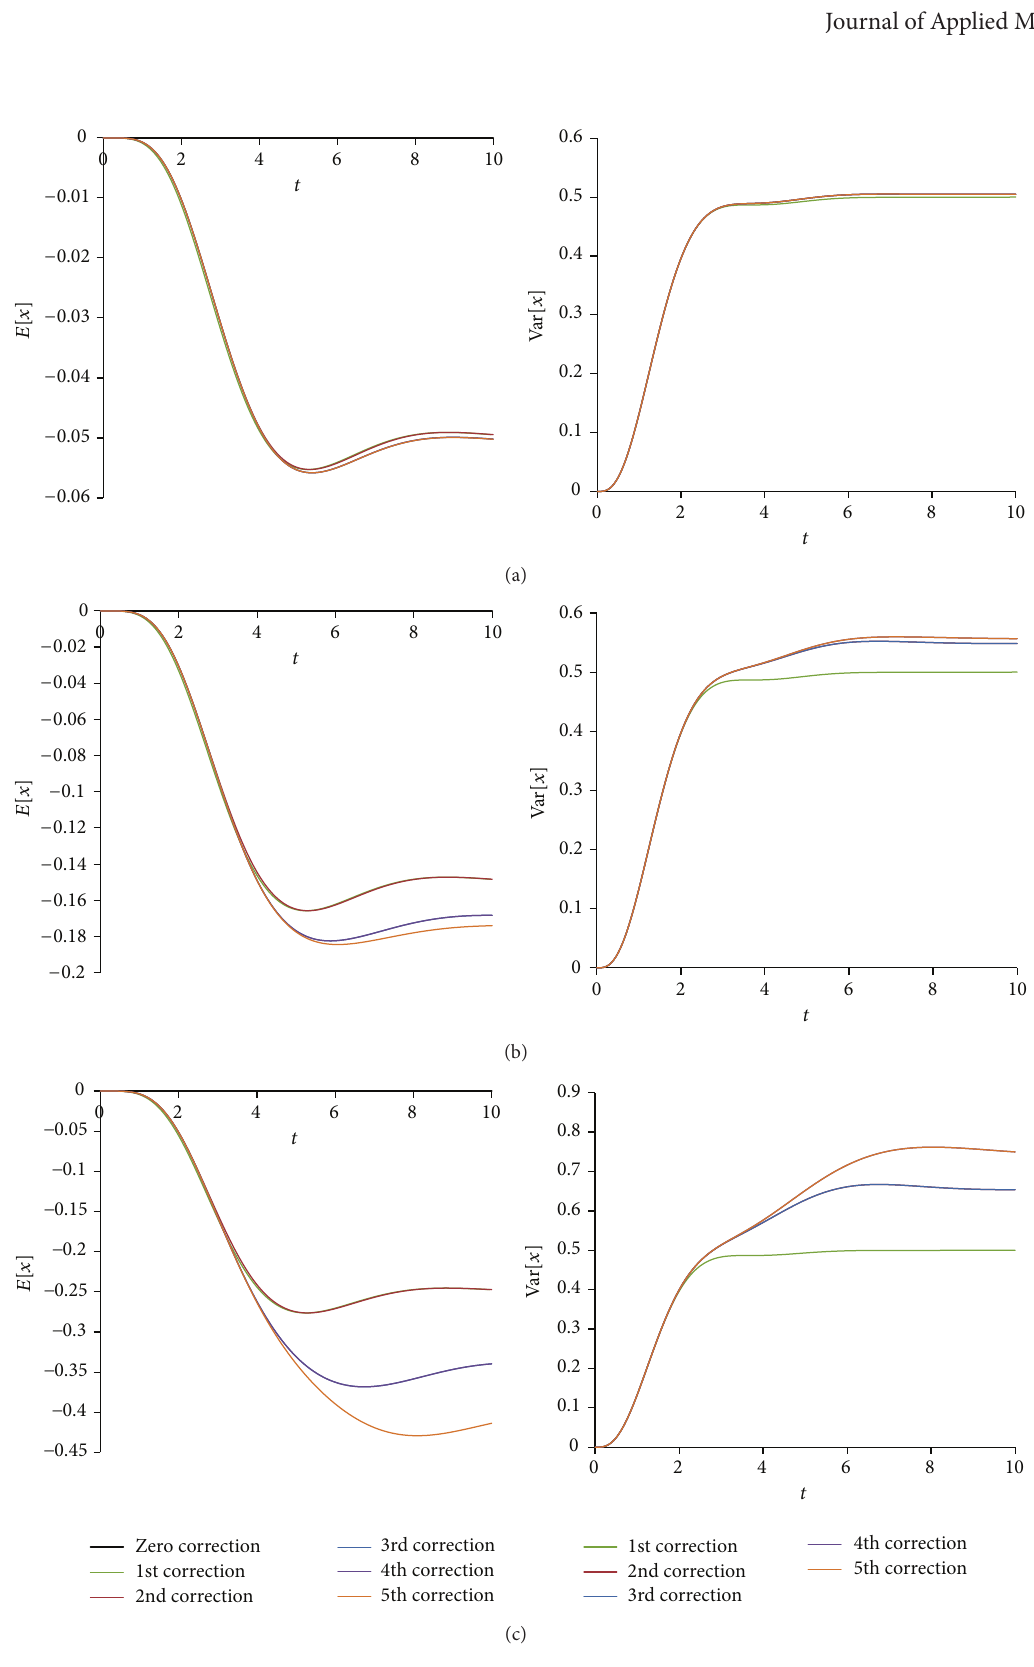
Figure 3: First-order response mean and variance for (a) 𝜀 = 0.1 , (b) 𝜀 = 0.3 , and (c) 𝜀 = 0.5